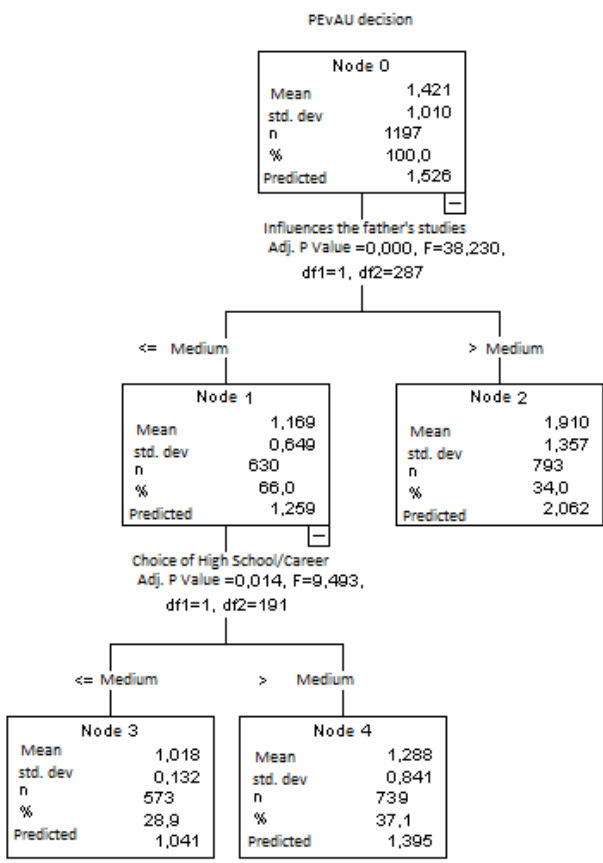
Figure 1. Classification tree for university entrance examination